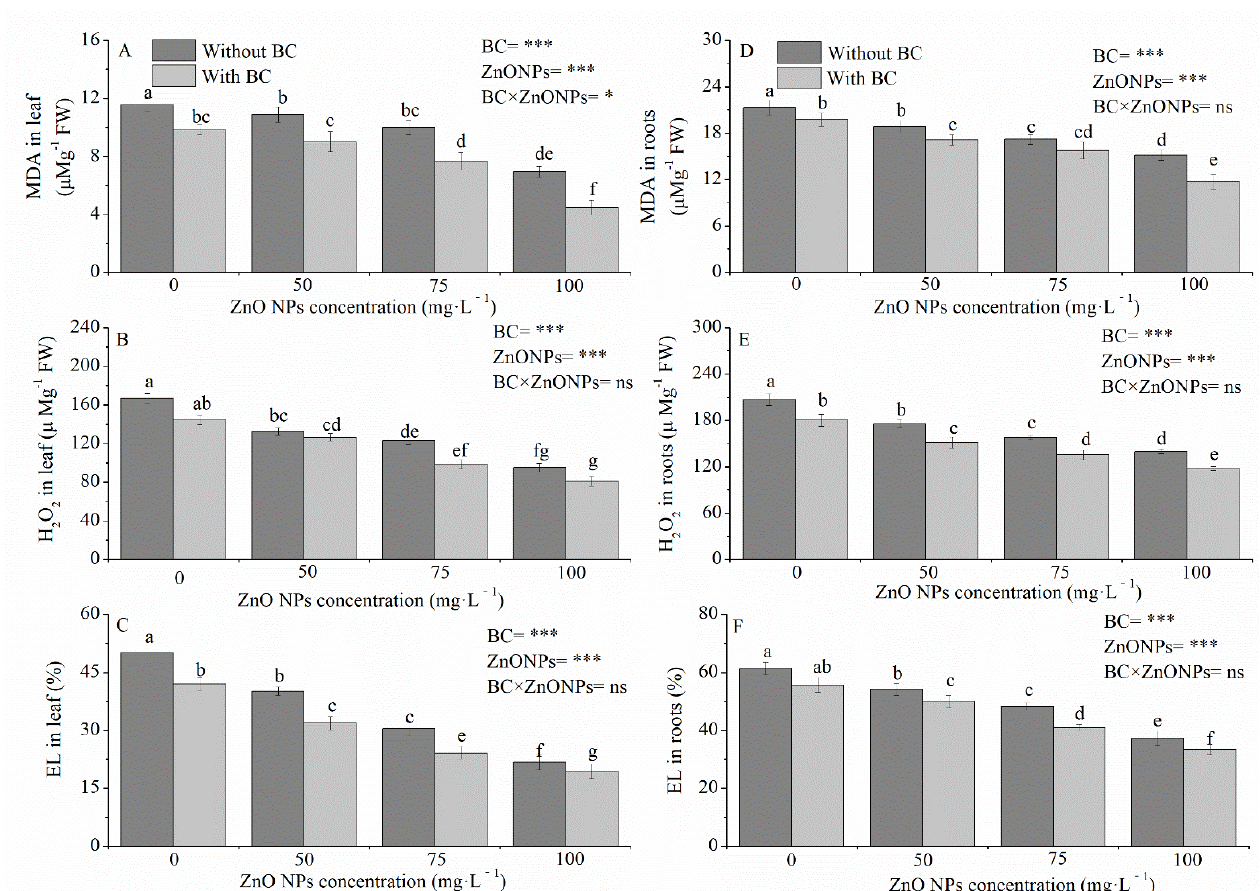
Figure 2. Effects of foliar-applied ZnO NPs alone and combined with bamboo biochar on MDA in ( A ) leaves, ( B ) H 2 O 2 in leaves, ( C ) El in leaf, ( D ) MDA in root, ( E ) H 2 O 2 in root, and ( F ) El in root in maize plants under Cd stress. In the figures: ns: non-significant; * significant at 0.05, and *** signif- icant at 0.001 levels.